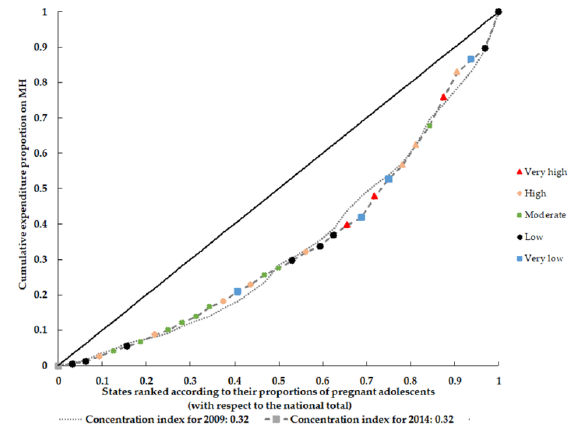
( a ) Distribution of MH expenditure for adolescent women. ( b ) Distribution of FP expenditure for adolescent women.